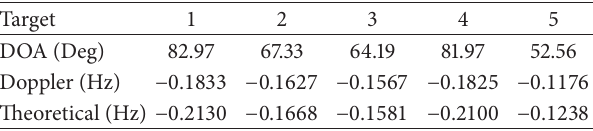
Table 2: DOA and Doppler